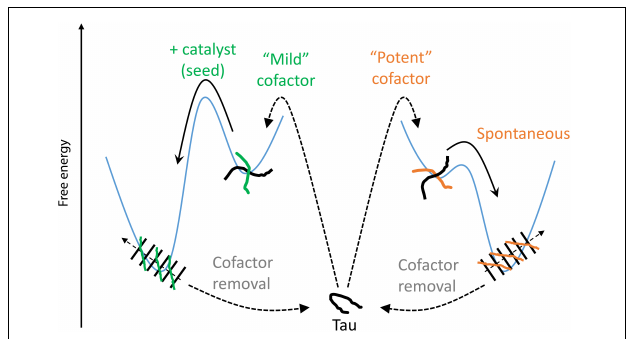
FIGURE 8 | Thermodynamic model of cofactor-induced aggregation and cofactor assisted seeding. Mild cofactors (e.g., polyU) form metastable complexes that do not evolve to β -sheet containing species due to a high energy barrier. This barrier can be overcome by a catalyst such as a seed. In contrast, potent cofactors (e.g., heparin) form intermediate complexes, or oligomers, that spontaneously evolved toward amyloid fibrils. In both cases, removal of the cofactors from the mature fibrils results in their depolymerization, showing that the tau-cofactor complex, and not tau only, is the building block of these